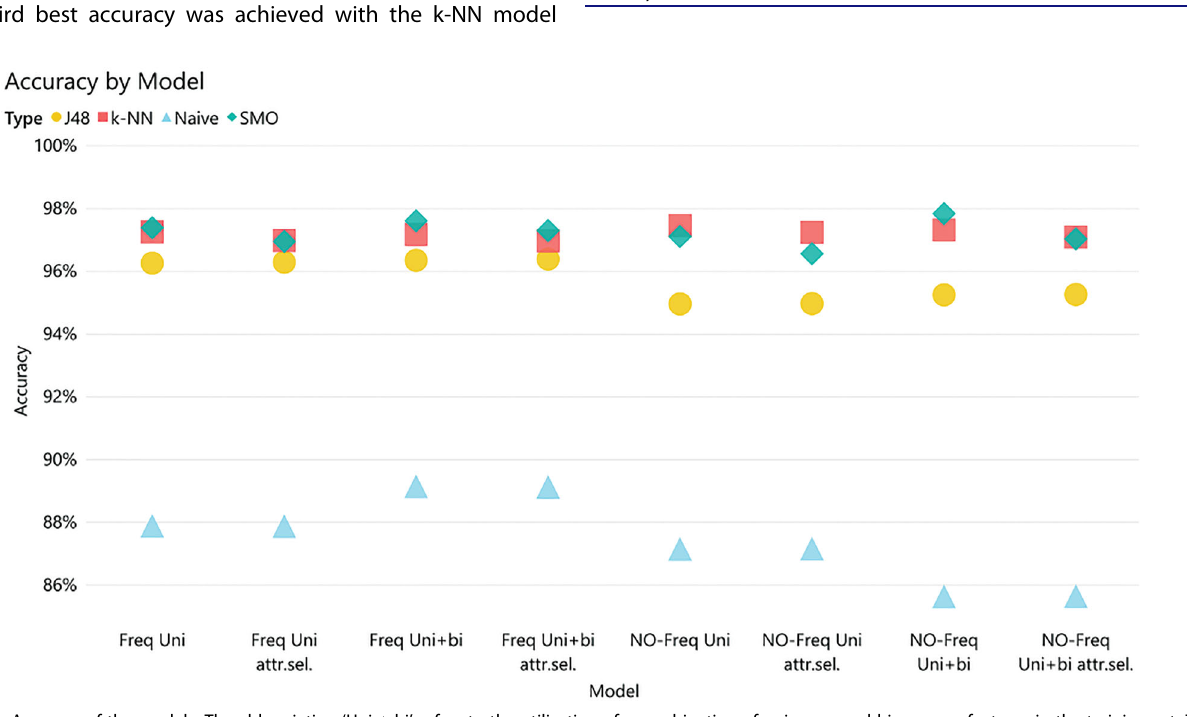
Figure 3. Accuracy of the models. The abbreviation ‘ Uni þ bi ’ refers to the utilization of a combination of unigrams and bigrams as features in the training-set. The abbreviation ‘ Attr. sel. ’ refers to the selection of the most relevant attributes in the training-set.